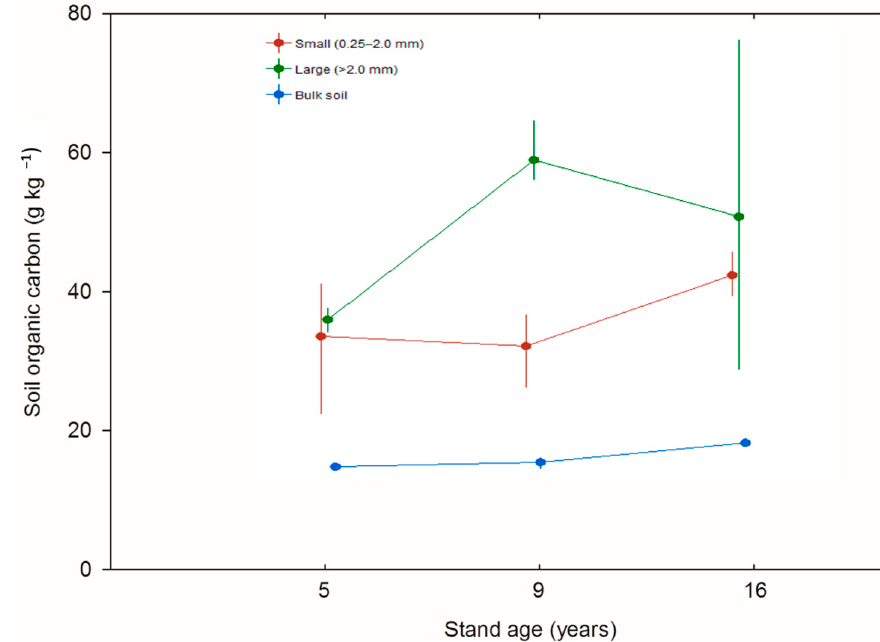
Figure 3. The effects of stand age on soil organic carbon content (SOC) in small and large aggregates ( n = 36) and bulk soil ( n = 12). Values are bootstrapped means ± 95% confidence intervals (CIs). Difference is significant at α = 0.05 if their CIs do not overlap the other’s mean.